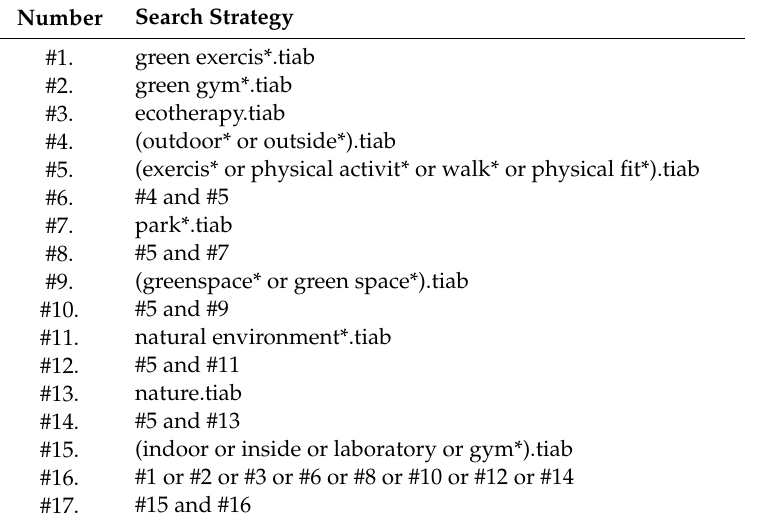
Table 1. Search strategy for PubMed (adapted for the other